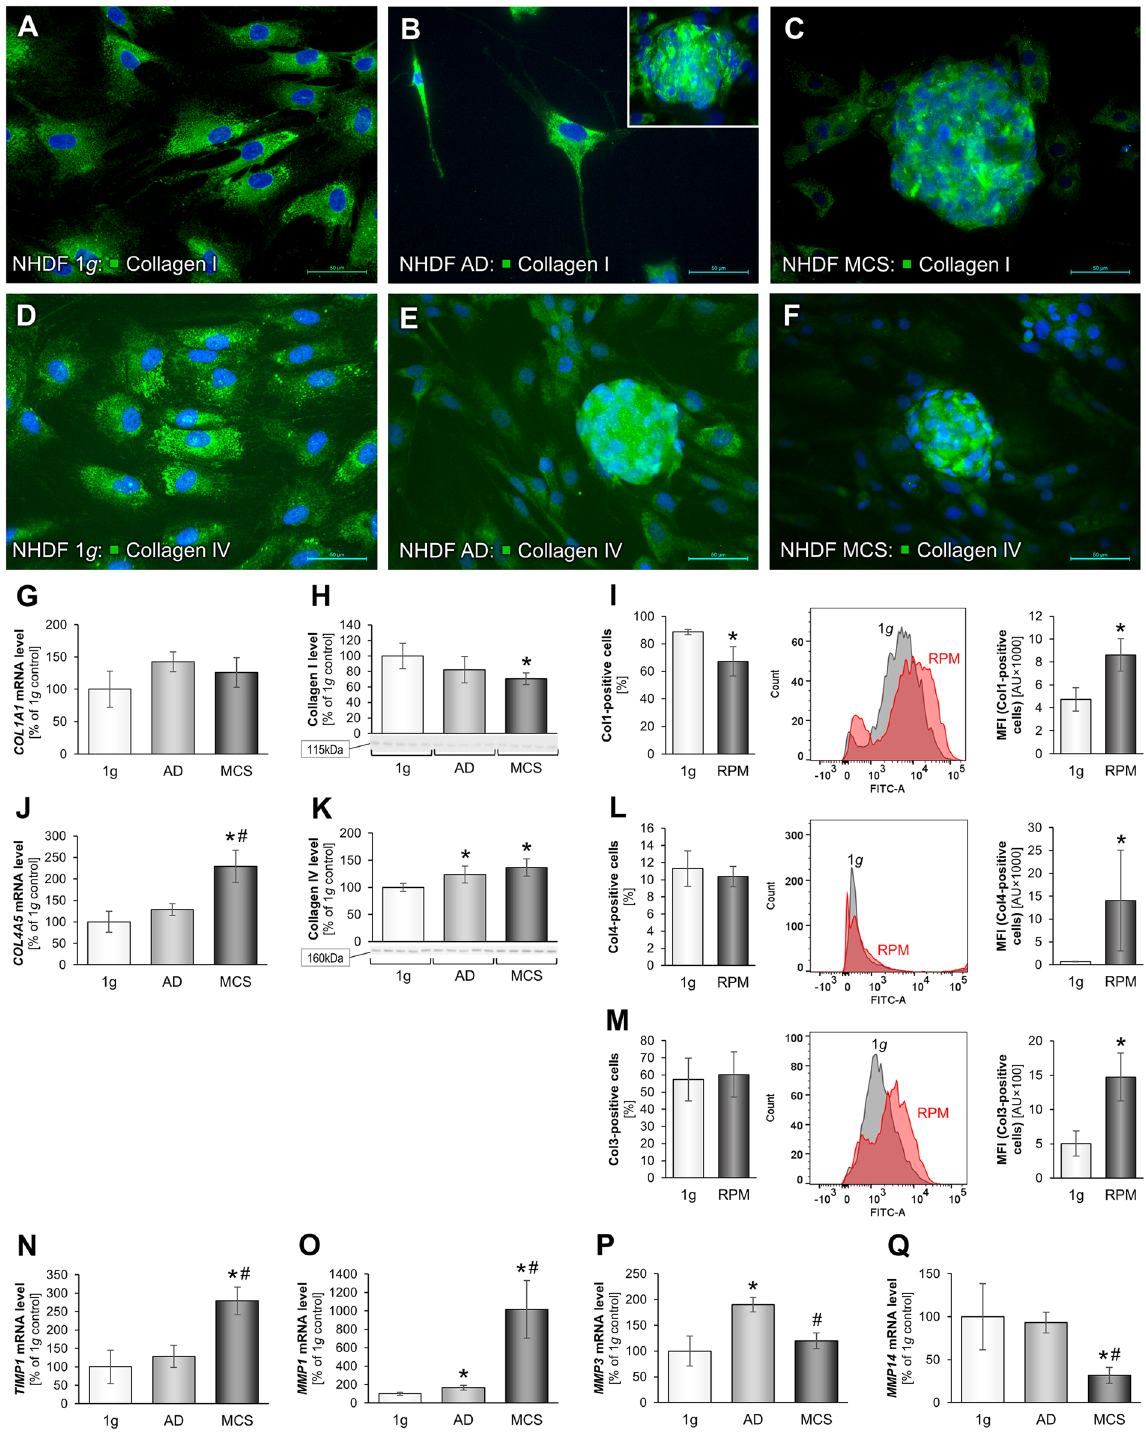
Figure 7. Alterations in collagen levels of juvenile NDHF cells following a 3-day exposure to microgravity: Immunofluorescence images of 1 g -control cells, RPM-AD and RPM-MCS of collagen-I ( A – C ) and collagen-IV ( D – F ). Transcriptional and translational collagen type I analysis: Quantitative gene expression levels of COL1A1 ( G ), intracellular collagen-I levels ( H ) and flow cytometric analysis of collagen type I-labeled cells ( I ). Quantitative gene expression levels of COL4A5 ( J ), intracellular collagen-I levels ( K ) and flow cytometric analysis of fibronectin-labeled cells ( L ). Flow cytometric analysis of collagen type III-labeled cells ( M ). Quantitative gene expression levels of TIMP1 ( N ), MMP1 ( O ), MMP3 ( P ) and MMP14 ( Q ). Full-length blots of cropped Western blot images are presented in Supplementary Fig. S6. * p < 0.05 1 g vs. RPM; # p < 0.05 AD vs. MCS. Scale bars: 50 µ